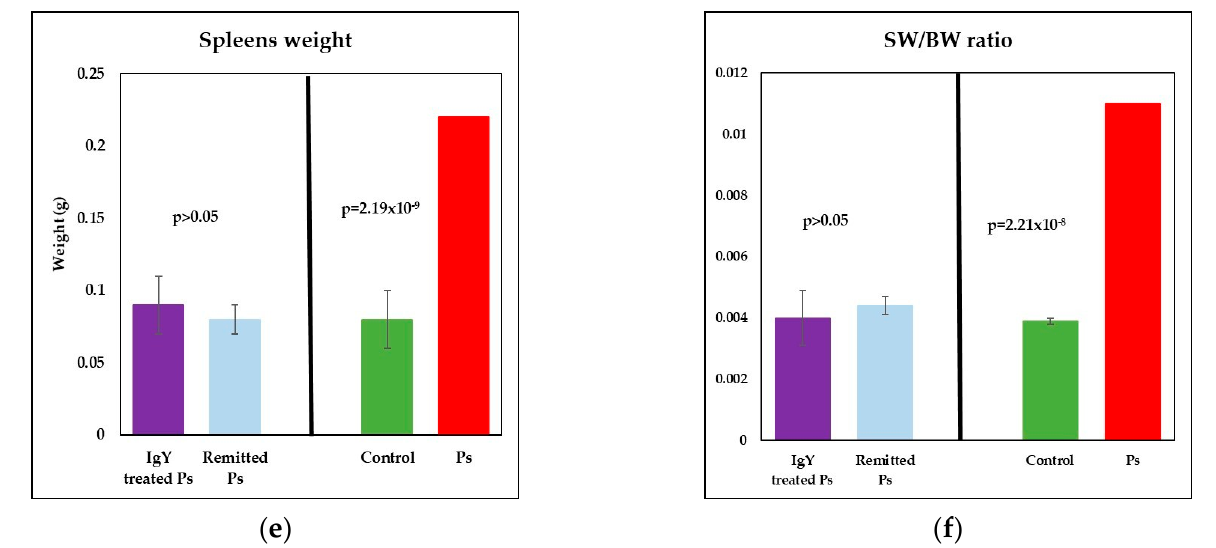
Figure 3. Representative images for the assessment of splenomegaly reduction. Spleens harvested from ( a ) mouse from IgY – treated Ps group; ( b ) mouse naturally remitted Ps group; ( c ) mouse from control group; ( d ) mouse from Ps group; ( e ) The weight of the spleens for IgY – treated Ps group (n = 12) (0.09 ± 0.02) as compared to naturally remitted Ps group (n = 8) (0.08 ± 0.01), control group (n = 8) (0,08 ± 0.01) and Ps group (n = 8) (0.22 ± 0.02); ( f ) SW/BW ratio for IgY-treated Ps group (n = 12) (0.0040 ± 0.0009) as compared to naturally remitted Ps group (n = 8) (0.0044 ± 0.0003), control group (n = 8) (0.0040 ± 0.0009) and Ps group ( n = 8) (0.011 ± 0.001). The results are presented as mean ± SD; n = number of mice).